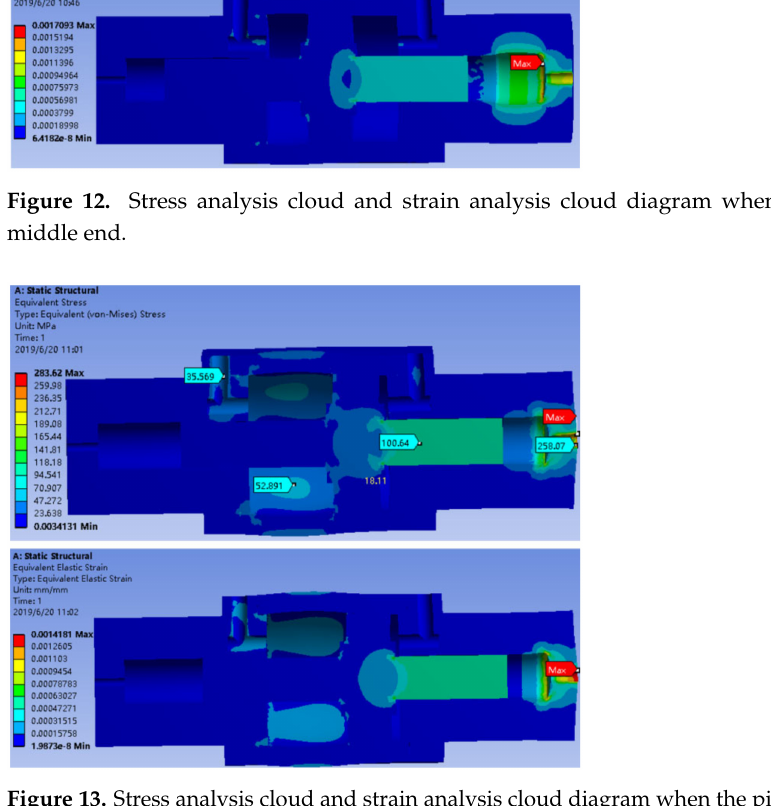
Figure 13. Stress analysis cloud and strain analysis cloud diagram when the piston is at the far